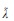
ACIs estimated on subsets of the data.A. Mean ACI for the 16 participants collectively, for conditions Al-, Ar-, high SNR, low SNR, firsttrials and lasttrials. Each individual ACI was estimated on 5,000 trials, with λ˜ = 1.191. In each ACI, the weights are divided by their maximum absolute value, and the formant trajectories are superimposed (same legend as in Fig. 6). B. Position of significant (orange) and non-significant clusters for each comparison (cluster-based non parametric test, p<0.05).